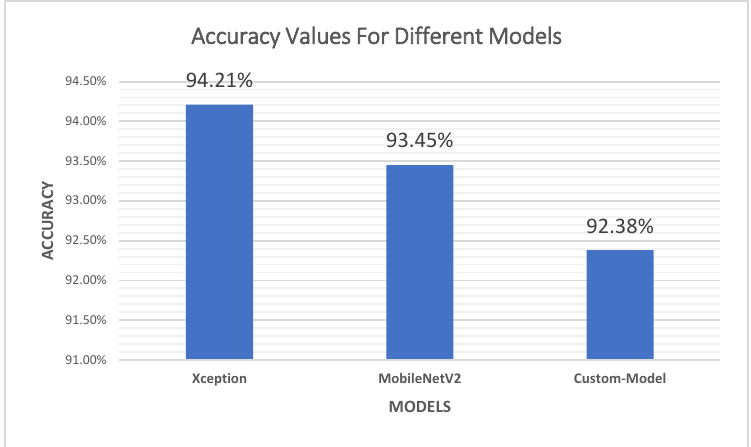
Figure 7. Accuracy plot for different models in terms of percentages.